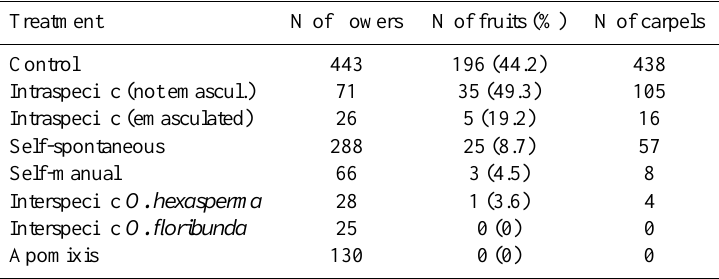
Table 2. Total number of O. spectabilis flowers used on each treatment, and number of fruits (and percentage) and carpels observed as a result of each treatment.